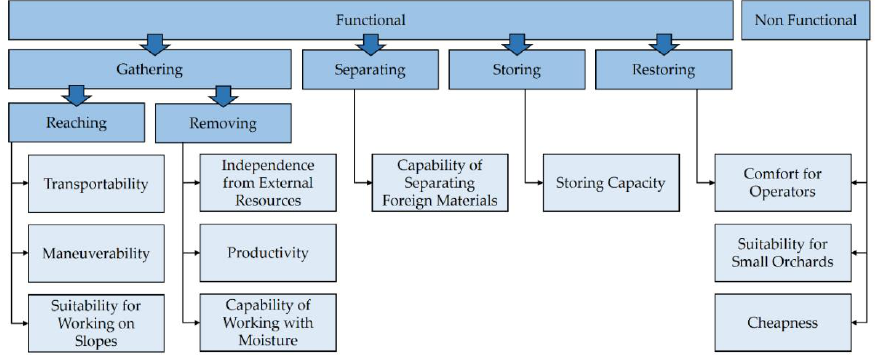
Figure 5. Competing factors and their classification.